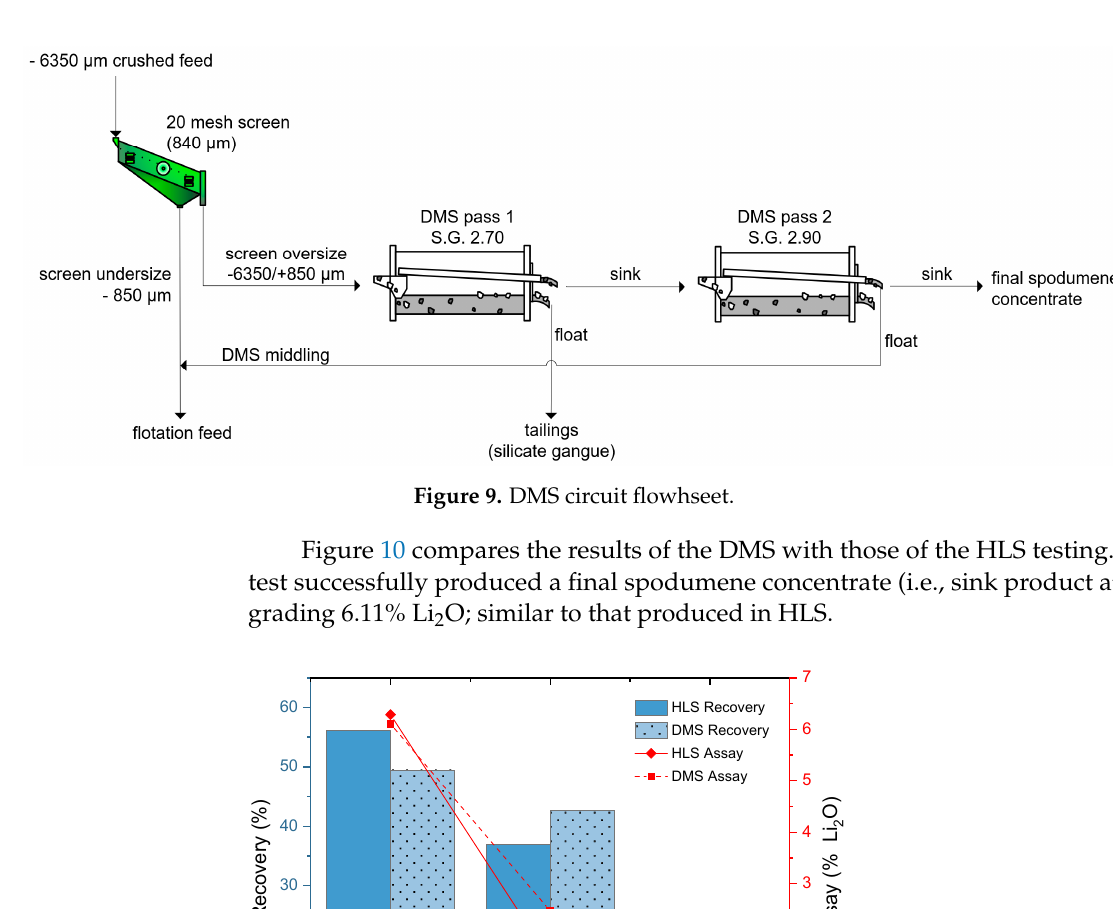
Figure 9. DMS circuit flowhseet.